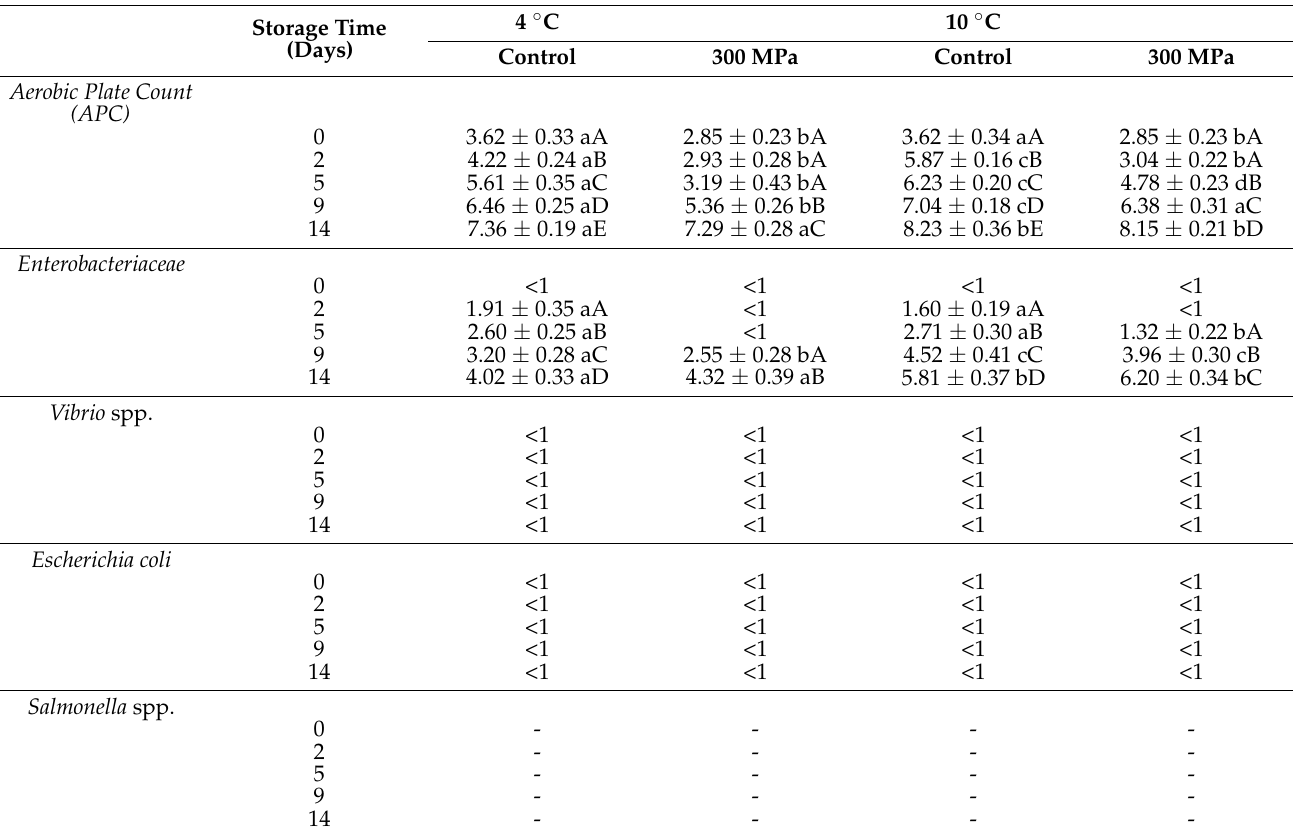
Table 5. Results for the microbial quality (Aerobic Plate Count, Enterobacteriaceae , Vibrio spp., Es- cherichia coli , Salmonella spp.) obtained for untreated (control) and HPP oysters (300 MPa for 2 min) over 14 days of storage (sampling points: 0, 2, 5, 9 and 14 days) and at different storage temperatures (4 and 10 ◦